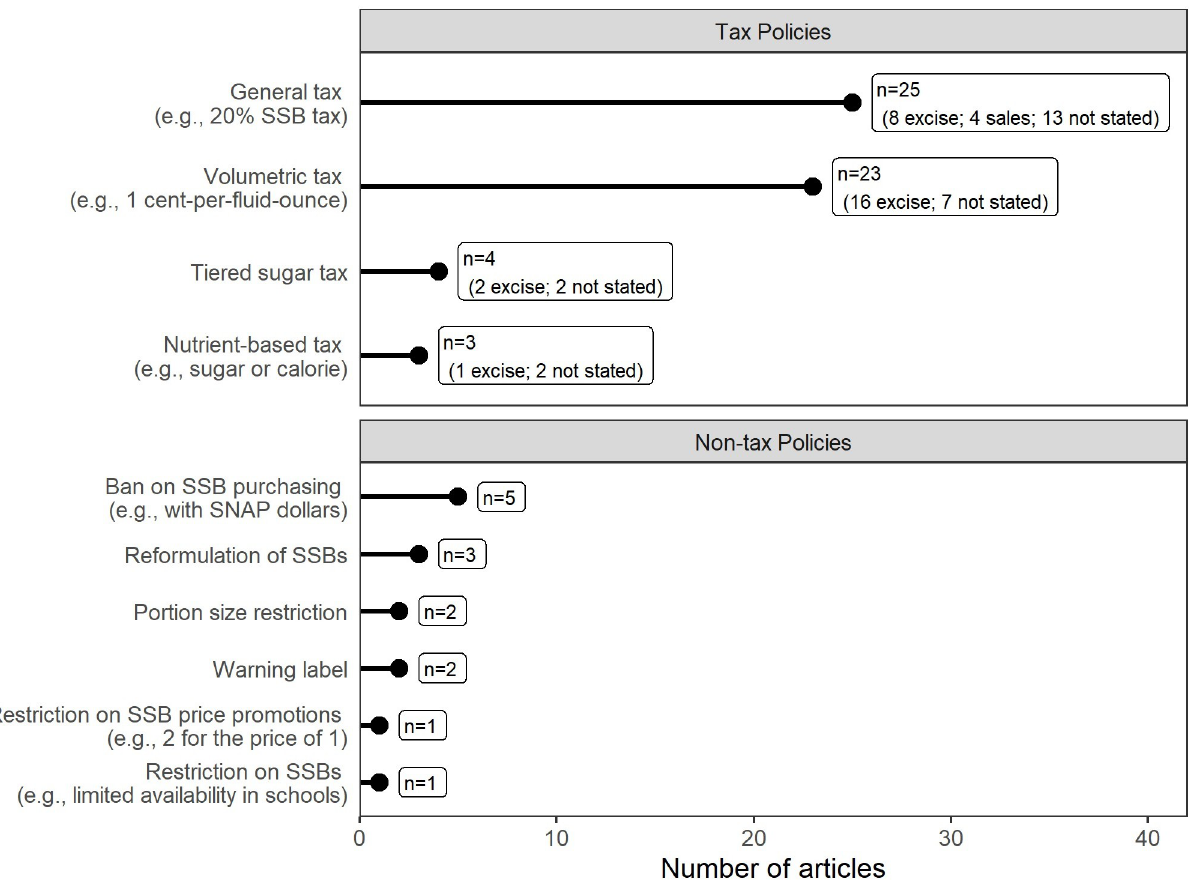
Fig 2. Sugar-sweetened beverage policies examined by simulation modeling studies (n = 61). Notes: SNAP = Supplemental Nutrition Assistance Program.